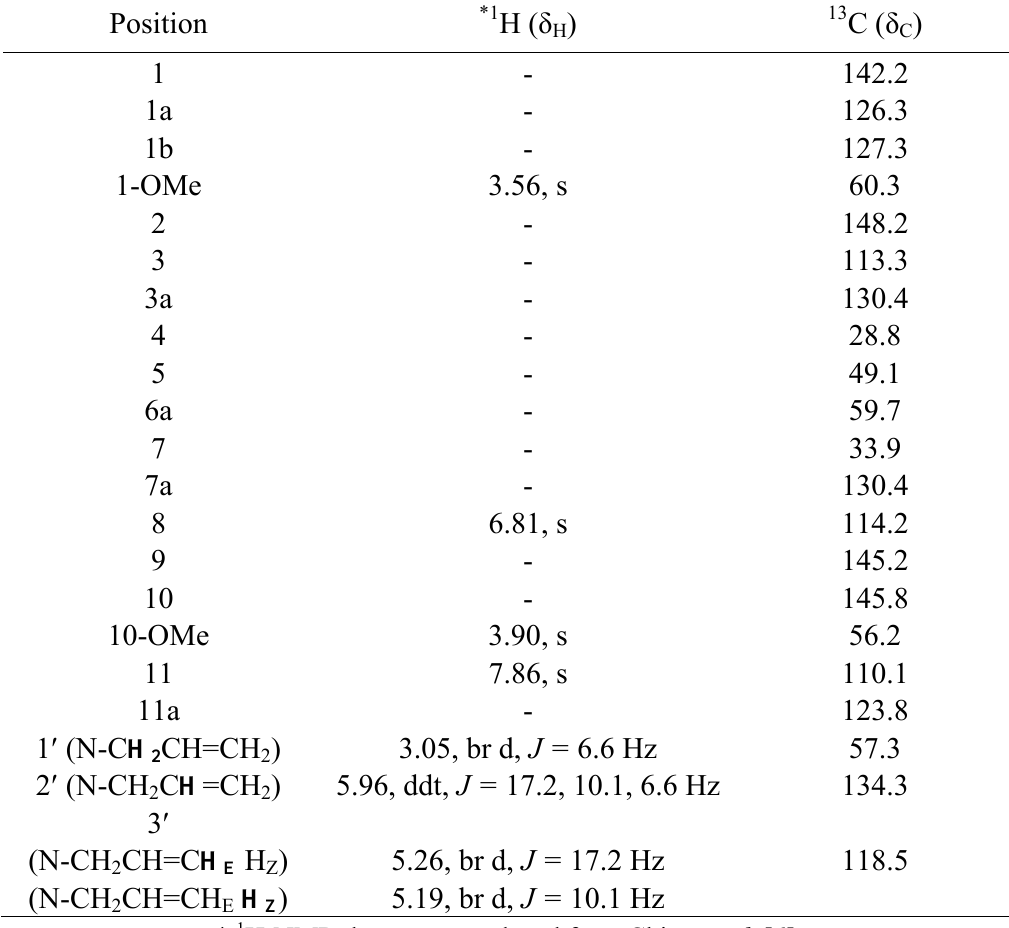
Table 2. 1 H and 13 C spectral data of N -allyllaurolitsine ( 2 ) in CDCl